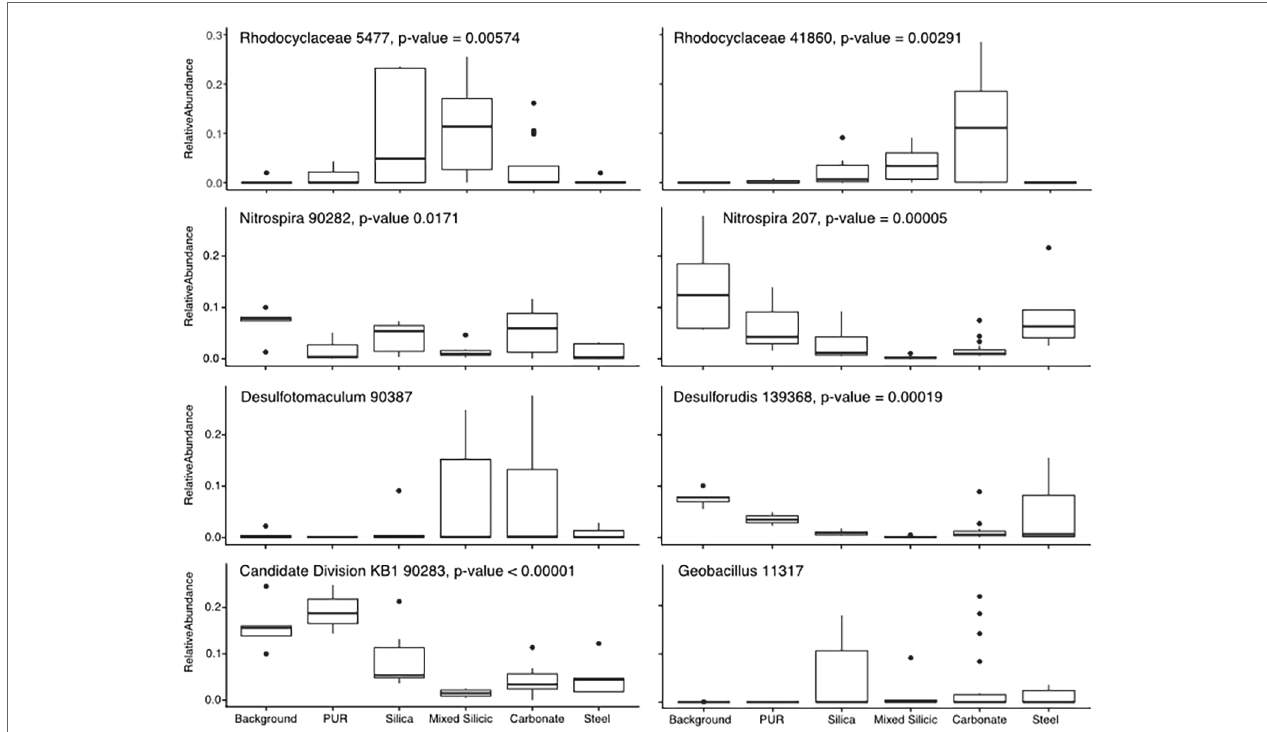
FIGURE 3 | Tukey-style box and whiskers plot showing the average relative abundance of similarity percentage (SIMPER)-identified important taxa by substrate group. For each grouping of samples, the box represents the upper and lower quartiles surrounding the median (line in the box). Whiskers represent the remaining spread of the data, apart from outlying data points (defined as points further from the median than 1.5× Interquartile Range). We isolated 16S data from Incubations 1, 2, and 5 (since they are least impacted by the organic substrate addition) and identified the eight most common OTUs to appear in SIMPER pairwise analysis of substrates (ANOSIM by substrate: R = 0.3863, p = 0.001). The relative abundances for these OTUs were averaged across the three Incubations in order to analyze mineral preference across the microbial community. “Background” samples include bailed filtered and unfiltered water ( n = 5); “PUR” indicates polyurethane foam block samples ( n = 3); “Carbonates” include calcite, dolomite, and HVD samples ( n = 18); “Silica” indicates glass wool samples ( n = 6); “Mixed” indicates MS lithology (tuff and lake sediments; n = 6); “Steel” indicates low carbon steel ball bearings ( n = 5). Plots are additionally labeled with the one-way ANOVA value of p if significant ( p < 0.05). The lack of significance for the Desulfotomaculum and Geobacillus OTUs was indicative of the fact that the Desulfotomaculum population crashed after Incubation 1 and that the Geobacillus was infrequently found on minerals, but that, when present, it was often in high abundance, supporting the idea that this organism is infrequently detected but typically detected at high